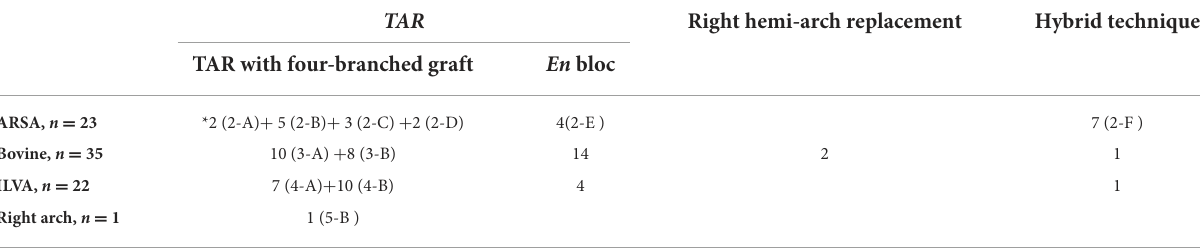
TABLE 1 Arch management strategies for different aortic arch deformities. TAR Right hemi-arch replacement Hybrid technique TAR with four-branched